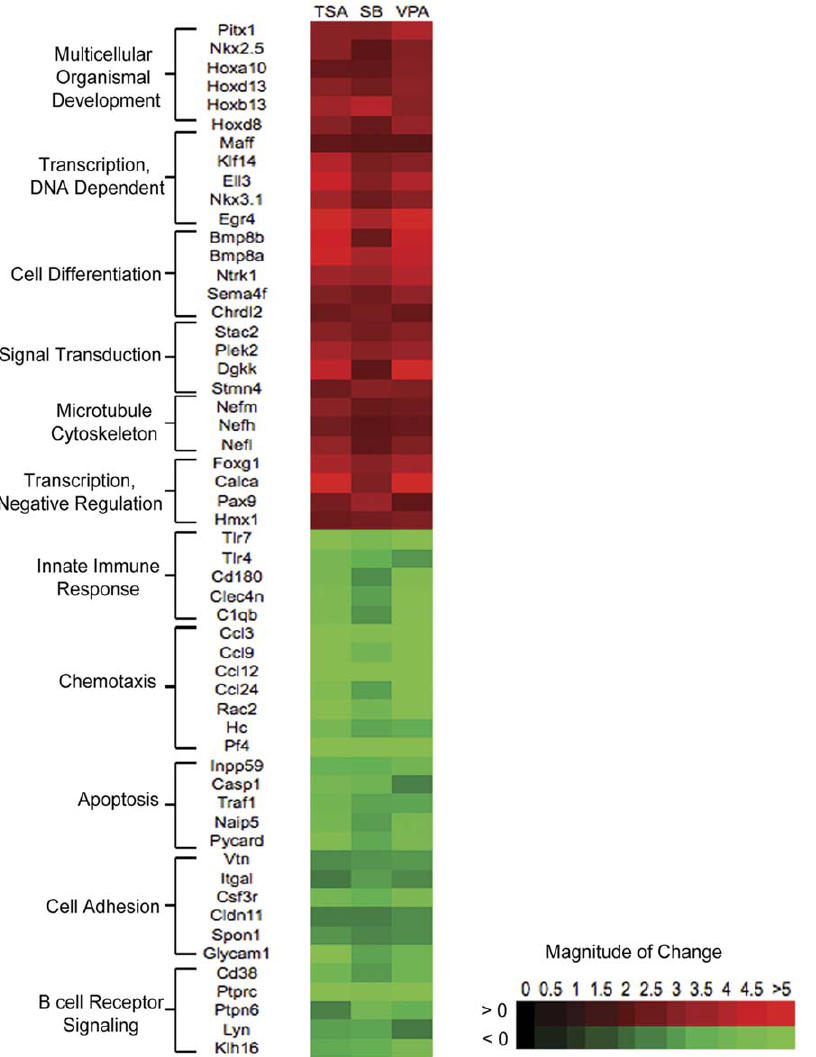
Figure 5. Summary of HDACi-induced expression changes for selected genes associated with GO terms. A representative sampling of GO terms was selected, and a subset of the genes associated with each GO term was plotted on a heat map to show relative expression of the genes of interest. Green= down-regulated genes, red= Up-regulated genes.